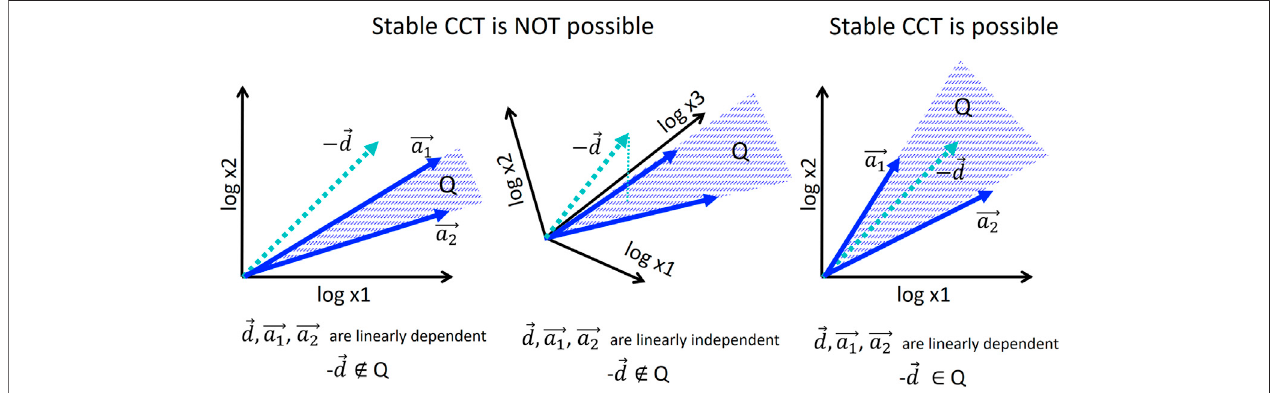
FIGURE 4 | Condition of existence of stable cell cycle trajectory in the model of allometric growth with switches. For illustration, only two growth vectors a 1 , a 2 are considered, and 2D or 3D embedding space. Stable piecewise linear trajectory is possible only if the negative of the cell division vector − d belongs to the convex cone Q (cid:1) (cid:1) m i λ i a i , λ i ≥ 0. Only in this case, the cyclic equality (cid:1) m i λ i a i + d (cid:1) 0 is possible. In general position, the condition can be met only when m ≥ n , where n is the dimensionality of the trajectory space (see text for the formal